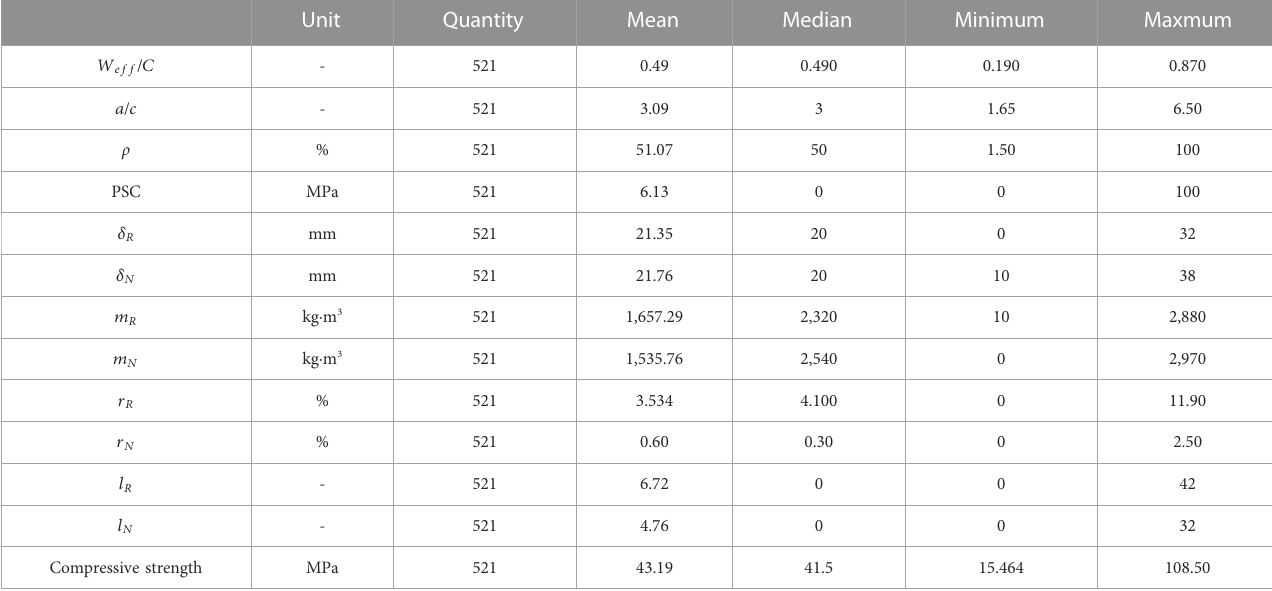
TABLE 1 Description of data used in this